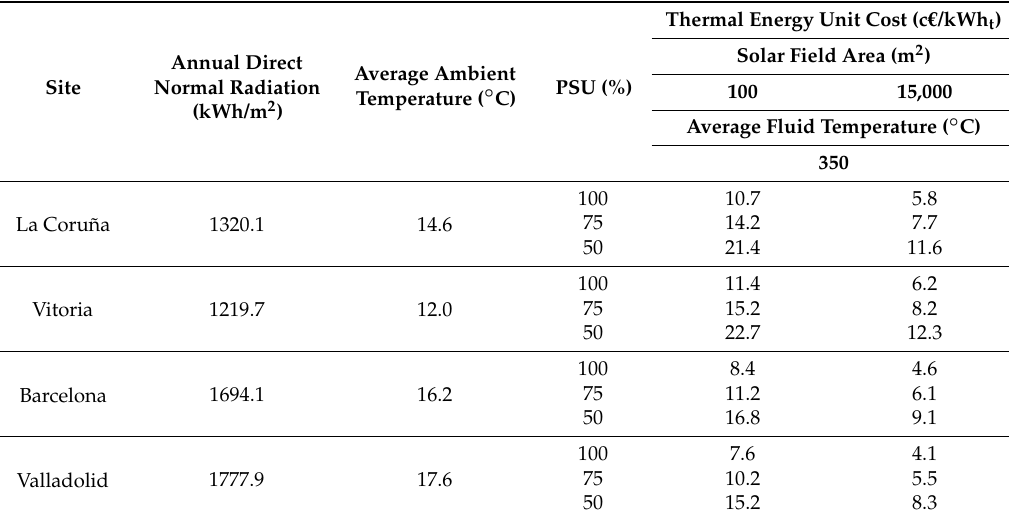
Table 23. Thermal energy unit cost, PTC